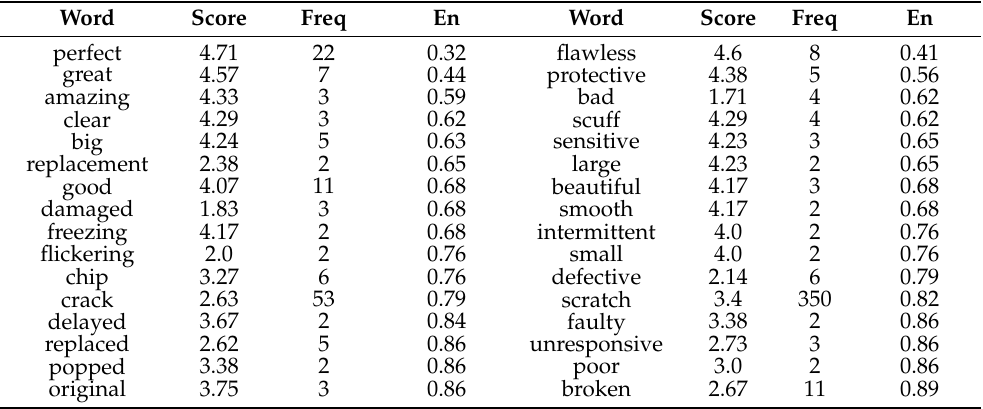
Table 12. Sentiment scores of screen-related words; “En” refers to “Entropy”.